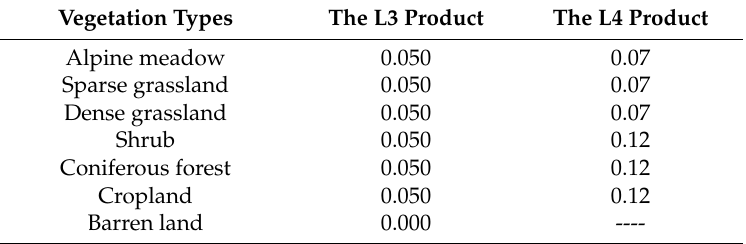
Table 7. Values of ω p used in both the SMAP L3 and L4 products under different vegetation types in the study area.